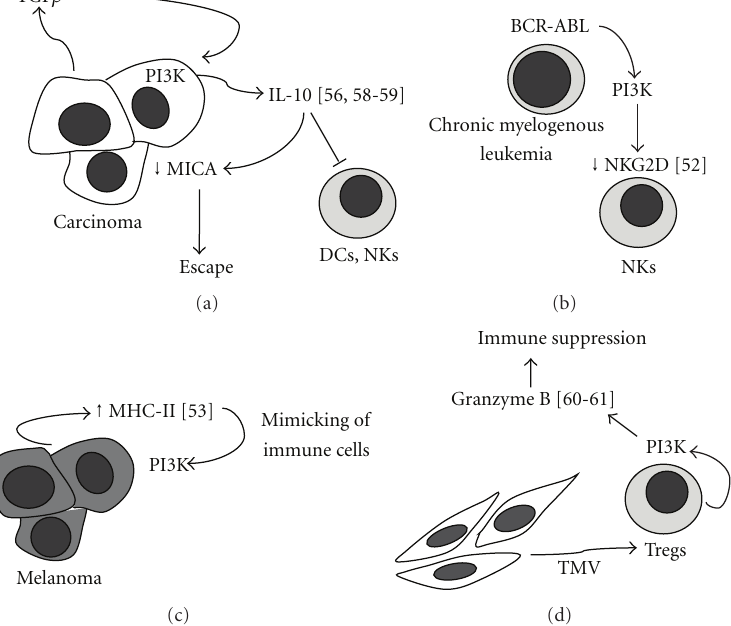
Figure 2: Examples of the major immune escape mechanisms of di ff erent types of cancers displaying the involvement of the PI3K signaling pathway. ↑ : upregulation; ↓ : downregulation; → : activation/secretion; (cid:5) : inhibition.